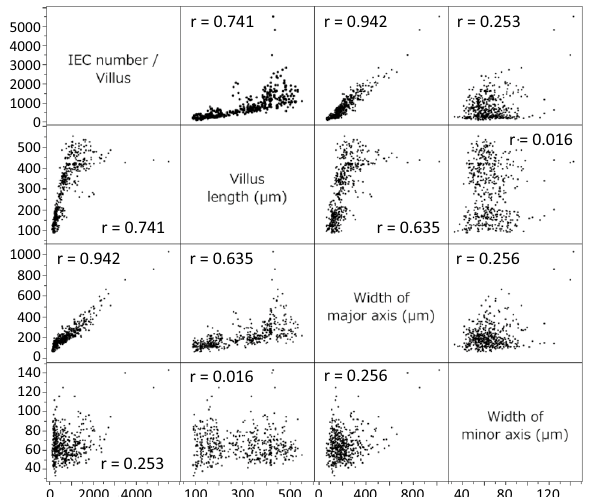
Figure 2. The factors responsible for IEC number in small intestine. A scatter plot matrix showing the relationships among IEC number per villus, villus length, width of major axis, and width of minor axis (n = 50 villi in 5 mice).